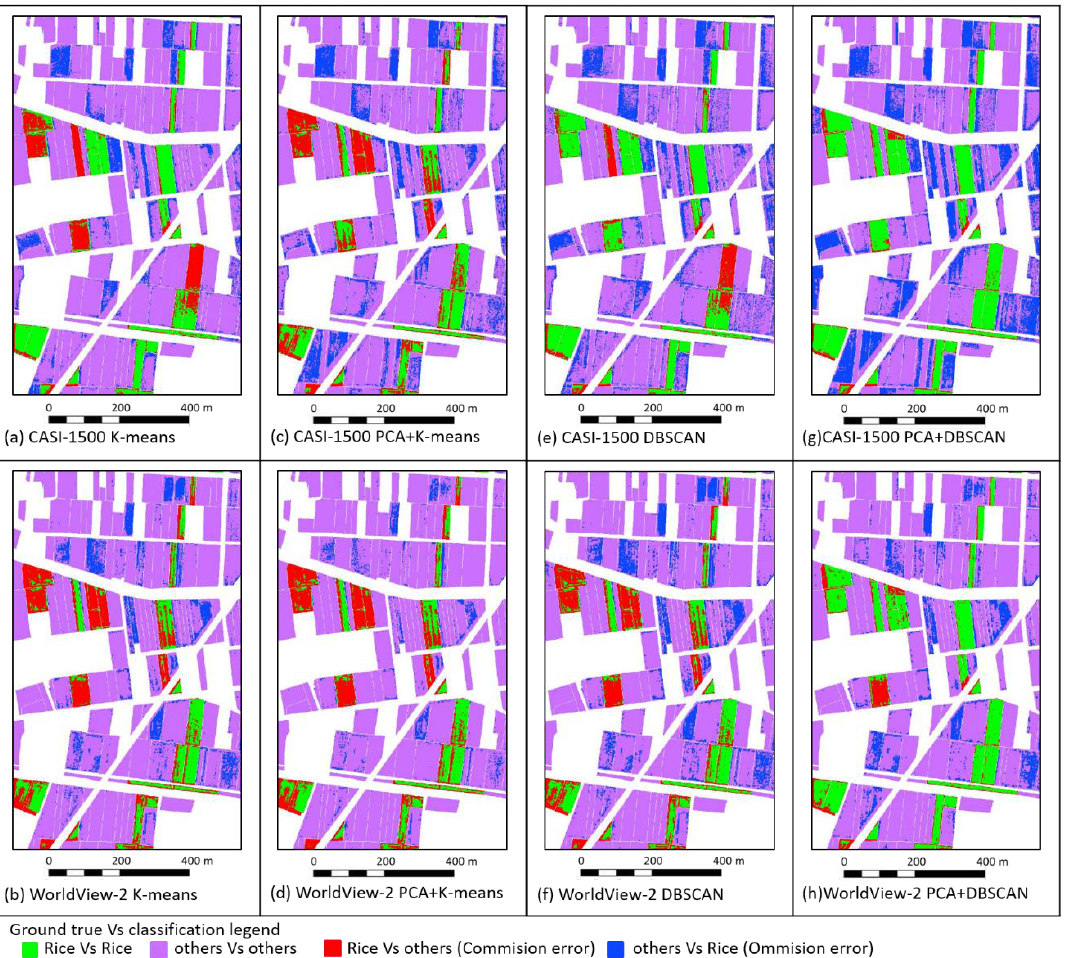
Figure 5. Thematic map of the full-size image unsupervised classification of the K-means and DBSCAN on CASI-1500 (hyperspectral) and WorldView-2 (multispectral) with/without feature selection. ( a ) CASI-1500 K-means; ( b ) WorldView-2 K-means; ( c ) CASI-1500 PCA+K-means; ( d ) WorldView-2 PCA+K-means; ( e ) CASI-1500 DBSCAN; ( f ) WorldView-2 DBSCAN; ( g ) CASI-1500 PCA+DBSCAN; and ( h ) WorldView-2 PCA+DBSCAN.